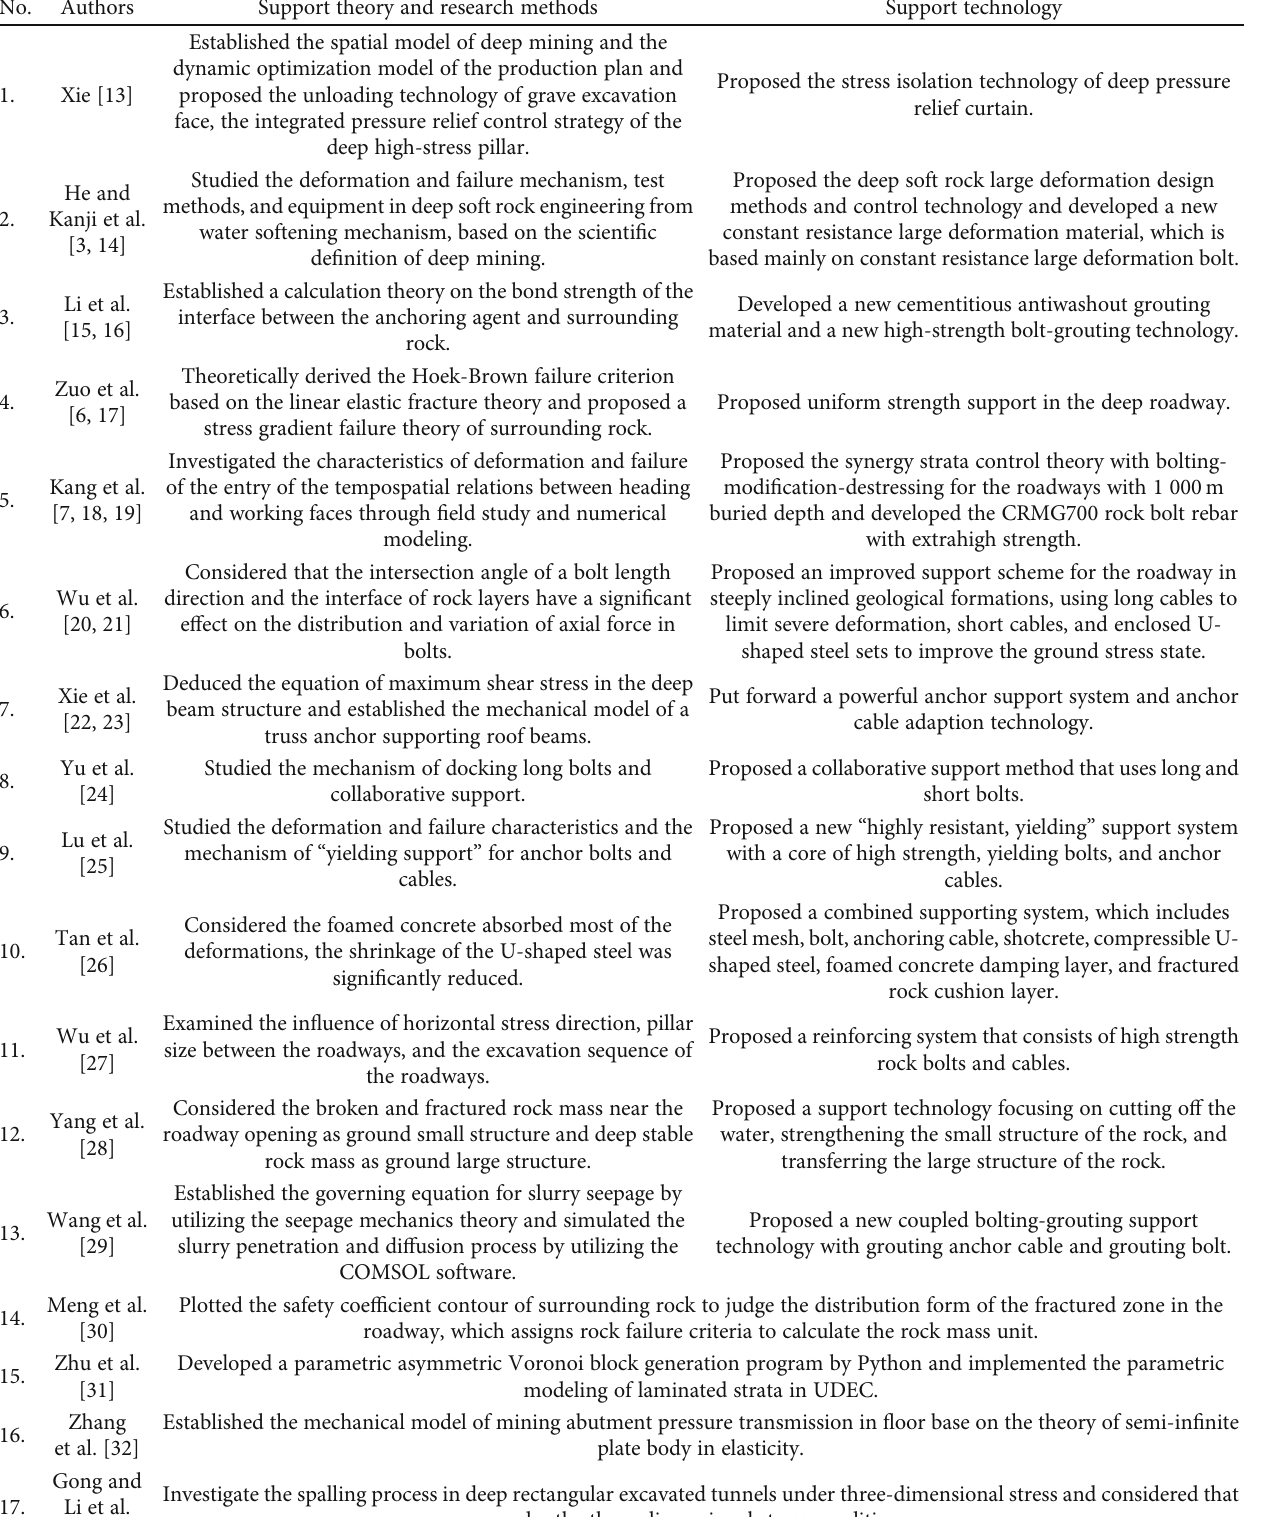
Table 1: Supporting theory and technology of deep-buried roadway in recent ten